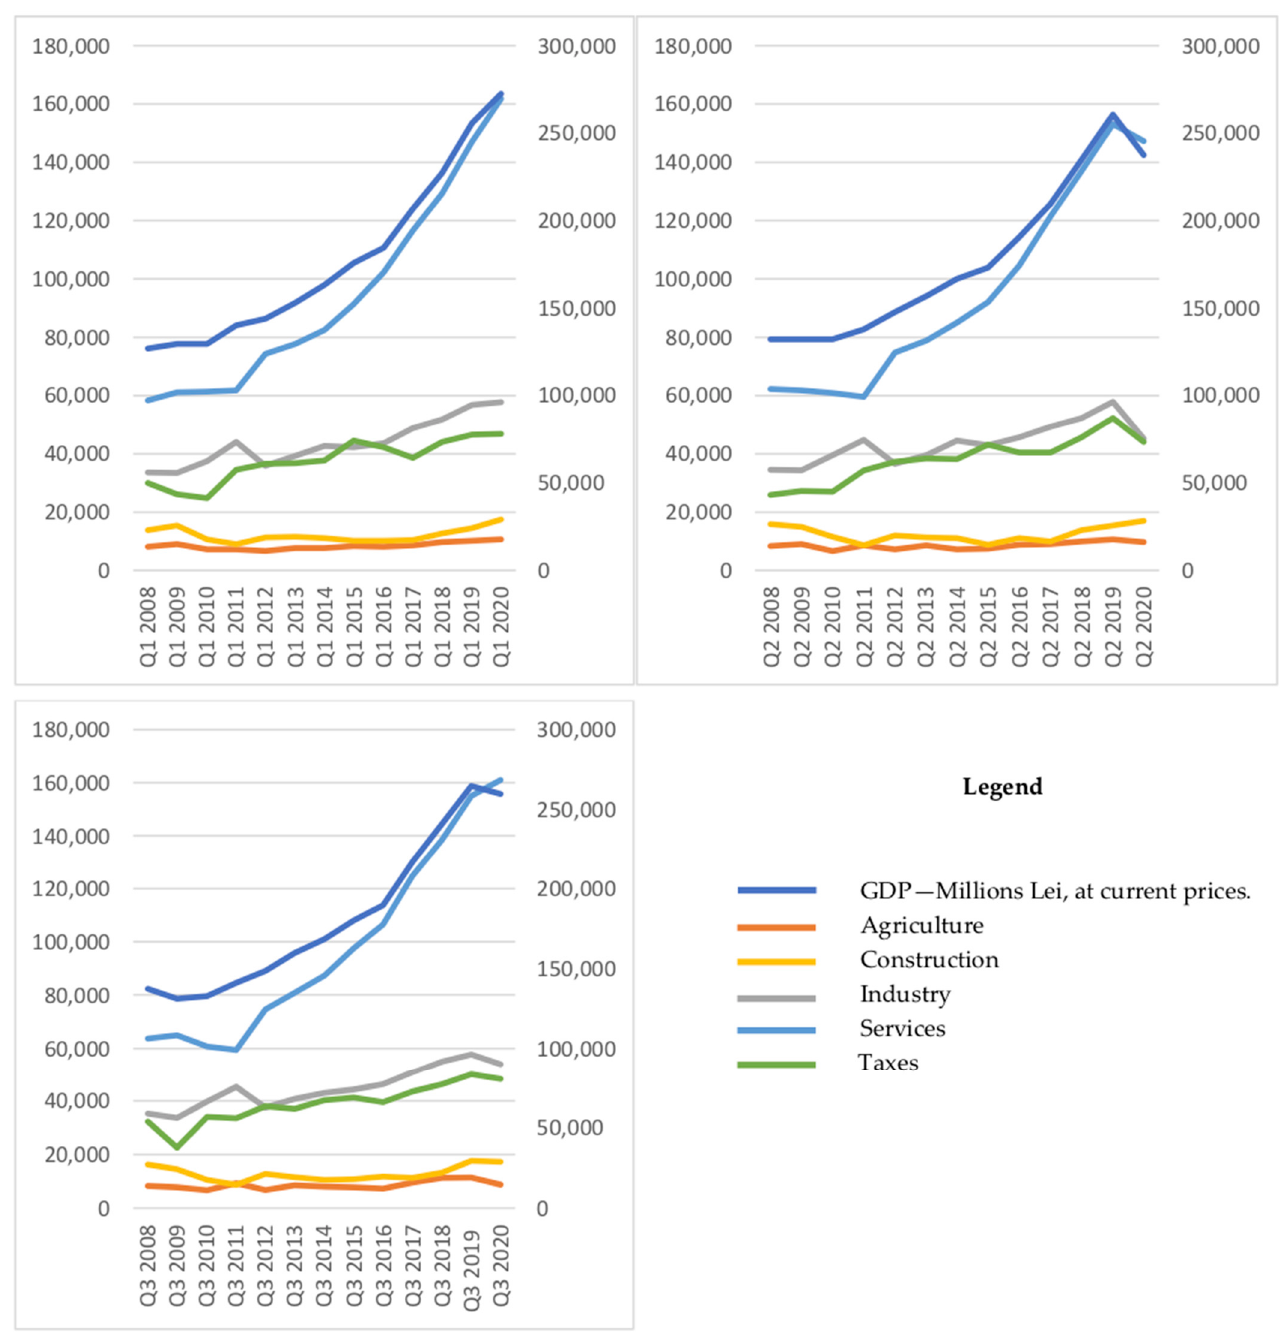
Figure 4. Romanian GDP (million lei, at current prices) for Q1, Q2, and Q3 between 2016 and 2020 (seasonally adjusted data). Source: own representation from data [53].